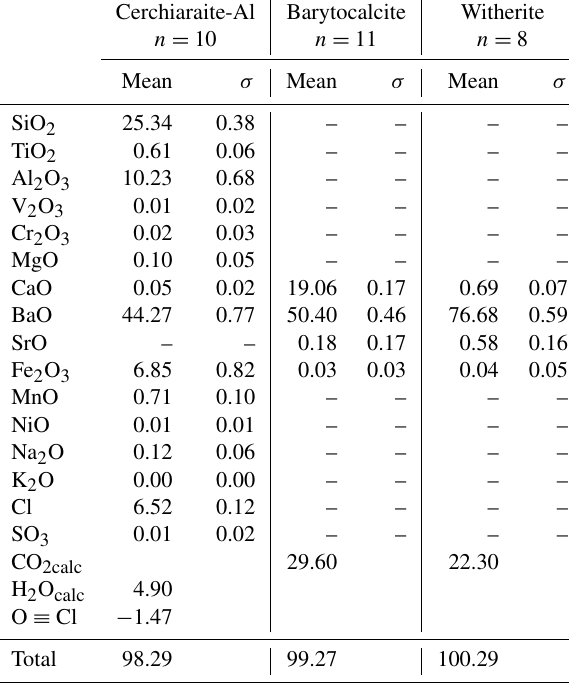
Table 3. Composition (in wt%) of barium-bearing minerals associ- ated with zinkgruvanite. Cerchiaraite-Al Barytocalcite Witherite